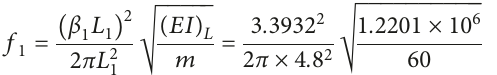
Figure 8: First vibrational modes for two unequal span continuous timber floor beams with pinned ends.